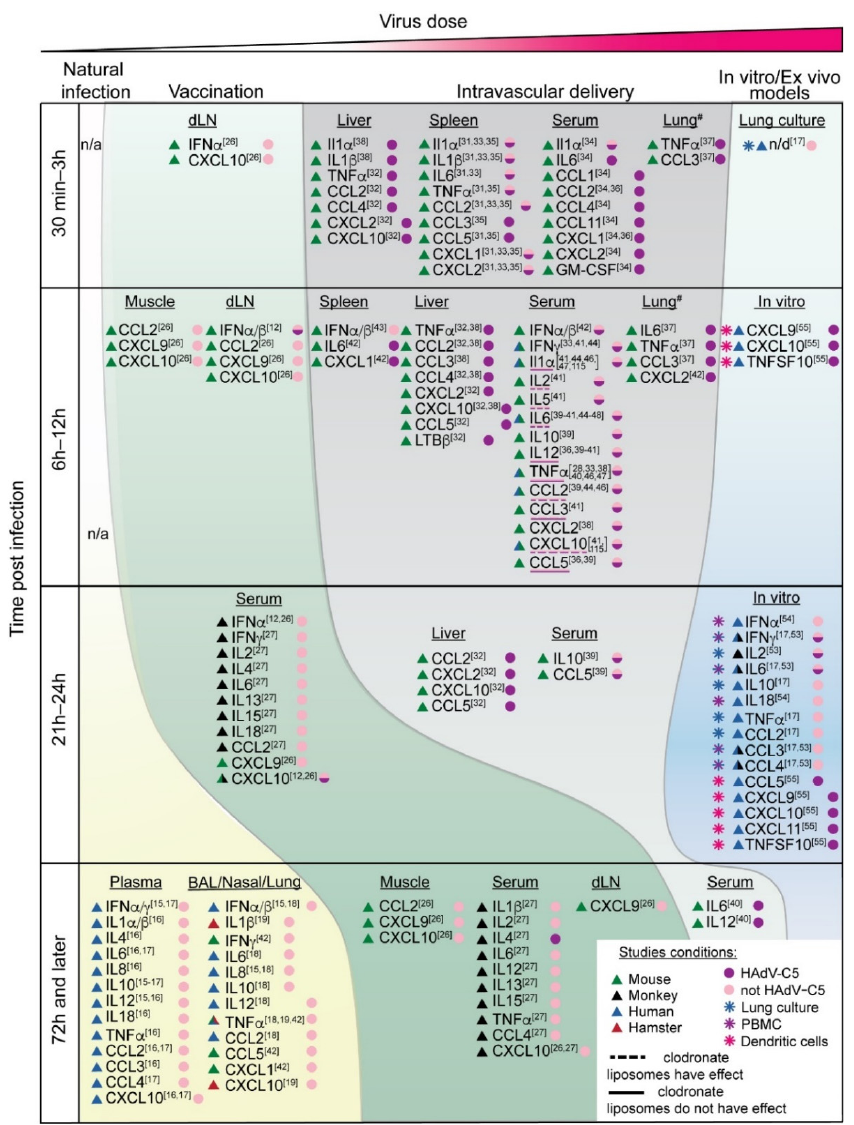
Figure 1. Cytokine responses to adenovirus in different biological contexts. The four areas are shaded in different colors, indicating adenovirus infection in various routes. The areas are positioned from left to right according to the virus dose received during infection. Vertically, the table is divided into four time periods from the earliest to the later times post infection. The deepest hues of the gradient colors show the peak times of cytokine response. The triangles indicate the species examined in the studies, and the color of the circles shows which adenovirus species were used. dLN—draining lymph node; BAL—bronchoalveolar lavage; n/a—data are not available; n/d—non detected; #—in this study, the virus was delivered intratracheally. The data for individual cytokines and chemokines, reported in references from [12–115], are shown with superscript numbers.